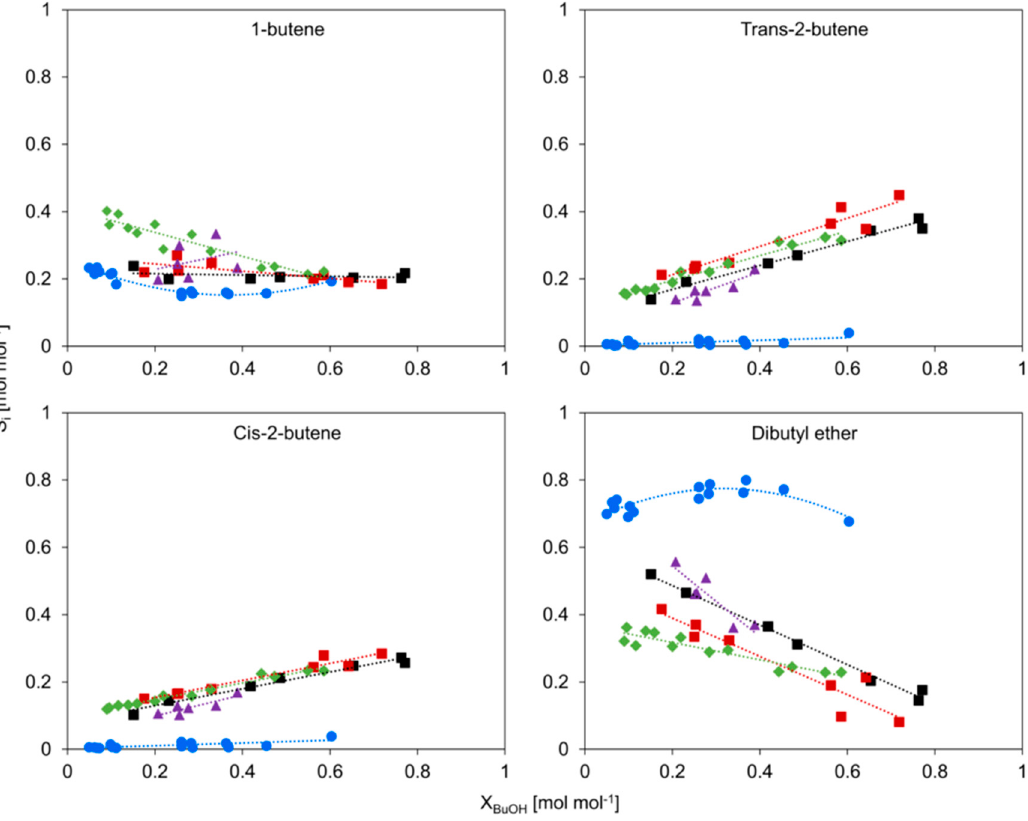
Figure 6. Site time yield (STY) as a function of the ratio of the amount of strong acid sites over medium Figure 7. Selectivity of products versus conversion, c-HZSM-5 ( (cid:4) , black), n-HZSM-5 ( (cid:4) , red), PM-50 / 50 Figure 7. Selectivity of products versus conversion, c-HZSM-5 (  , black), n-HZSM-5 (  , red), PM- acid sites. Symbols: c-HZSM-5 (  , black), n-HZSM-5 (  , red), PM-50/50 (  , purple), Hybrid-50/50 (  , ( (cid:78) , purple), Hybrid-50 / 50 ( 50/50 (  , purple), Hybrid-50/50 (  , green), and γ -Al 2 O 3 (  , blue). Temperature = 513 K, inlet pressure K, inlet pressure of n-butanol = 29 kPa, total pressure green), and γ -Al 2 O 3 (  , blue). Temperature = 513 of n-butanol = 29 kPa, total pressure = 5 bar. = 5